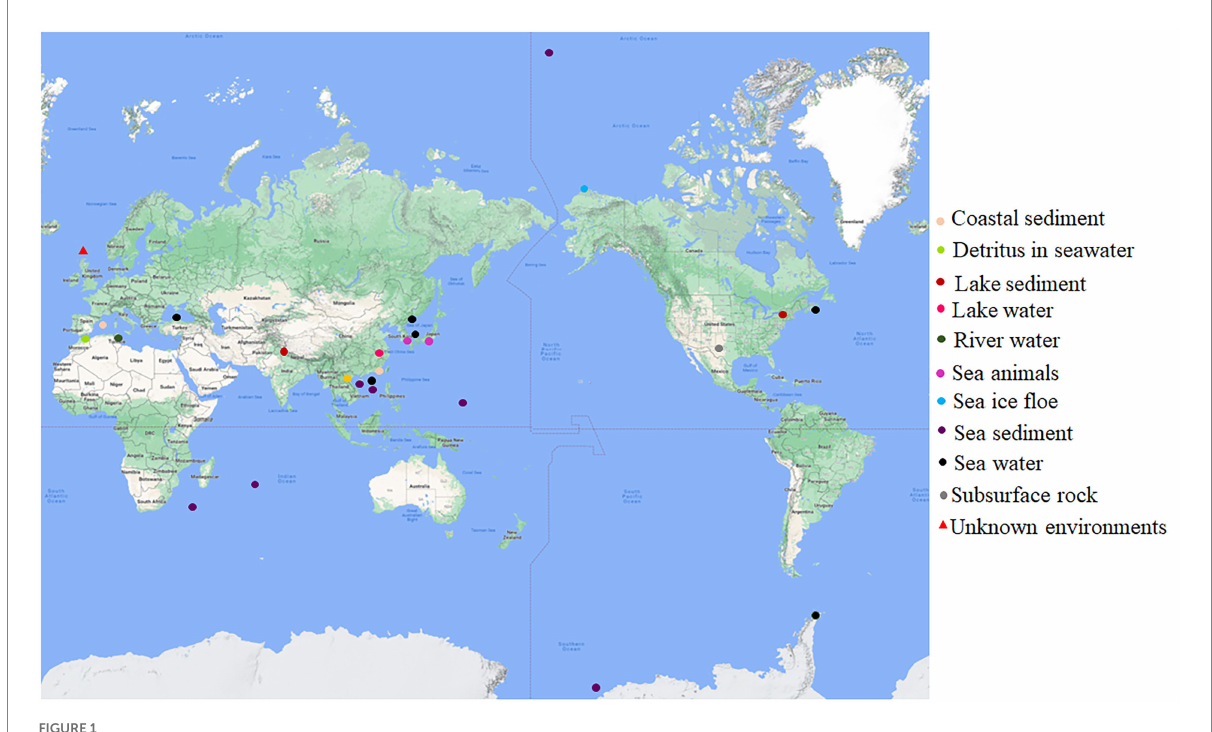
FIGURE 1 Global distribution of the bacteria with capability for extracellular reduction of iodate. Their original habits are indicated. See Supplementary Table S1 for